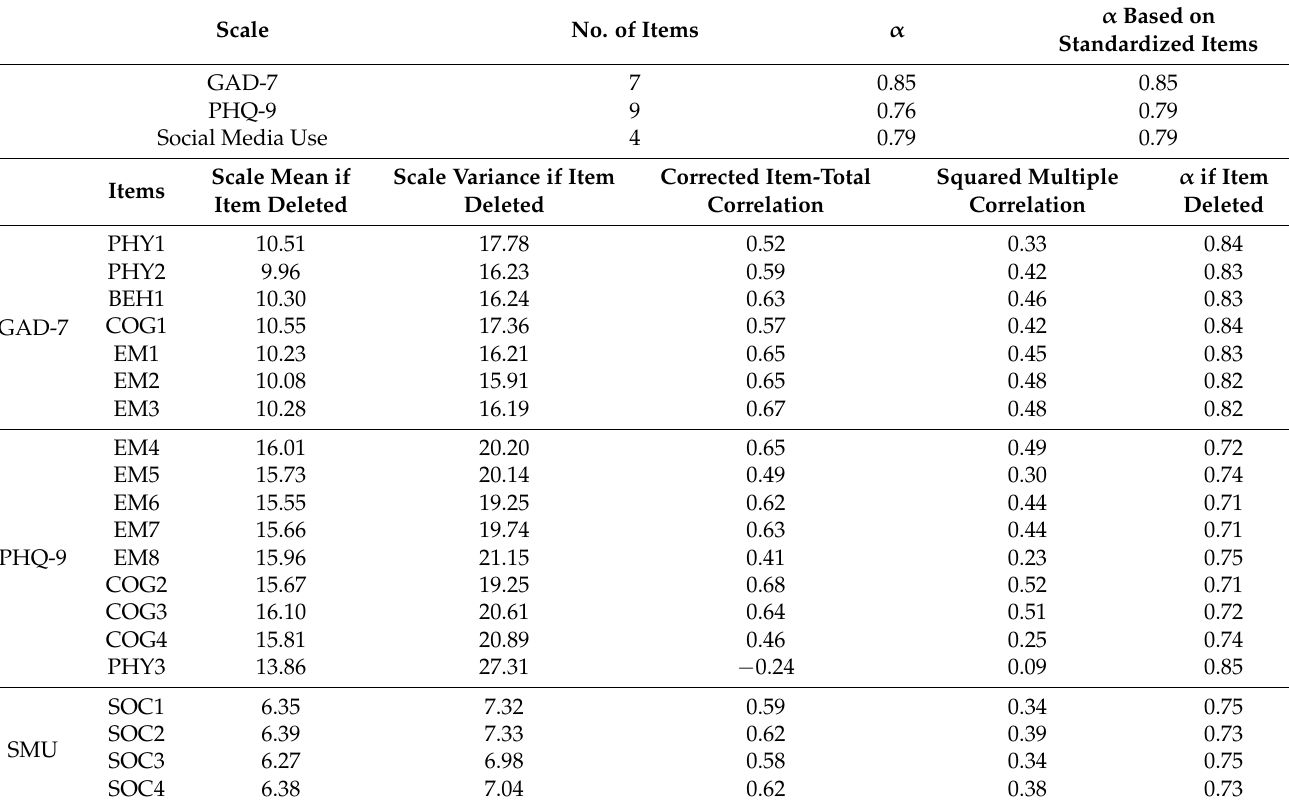
Table 4. Reliability table for everyday emotions scale and social media use items.